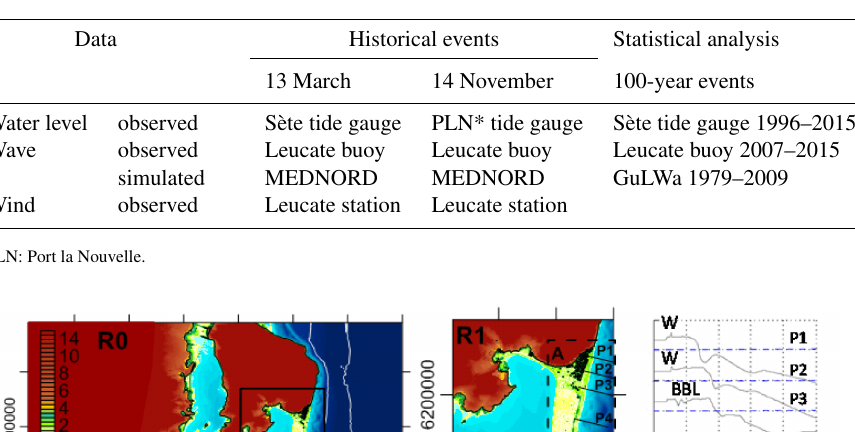
Table 1. Observed and simulated database.